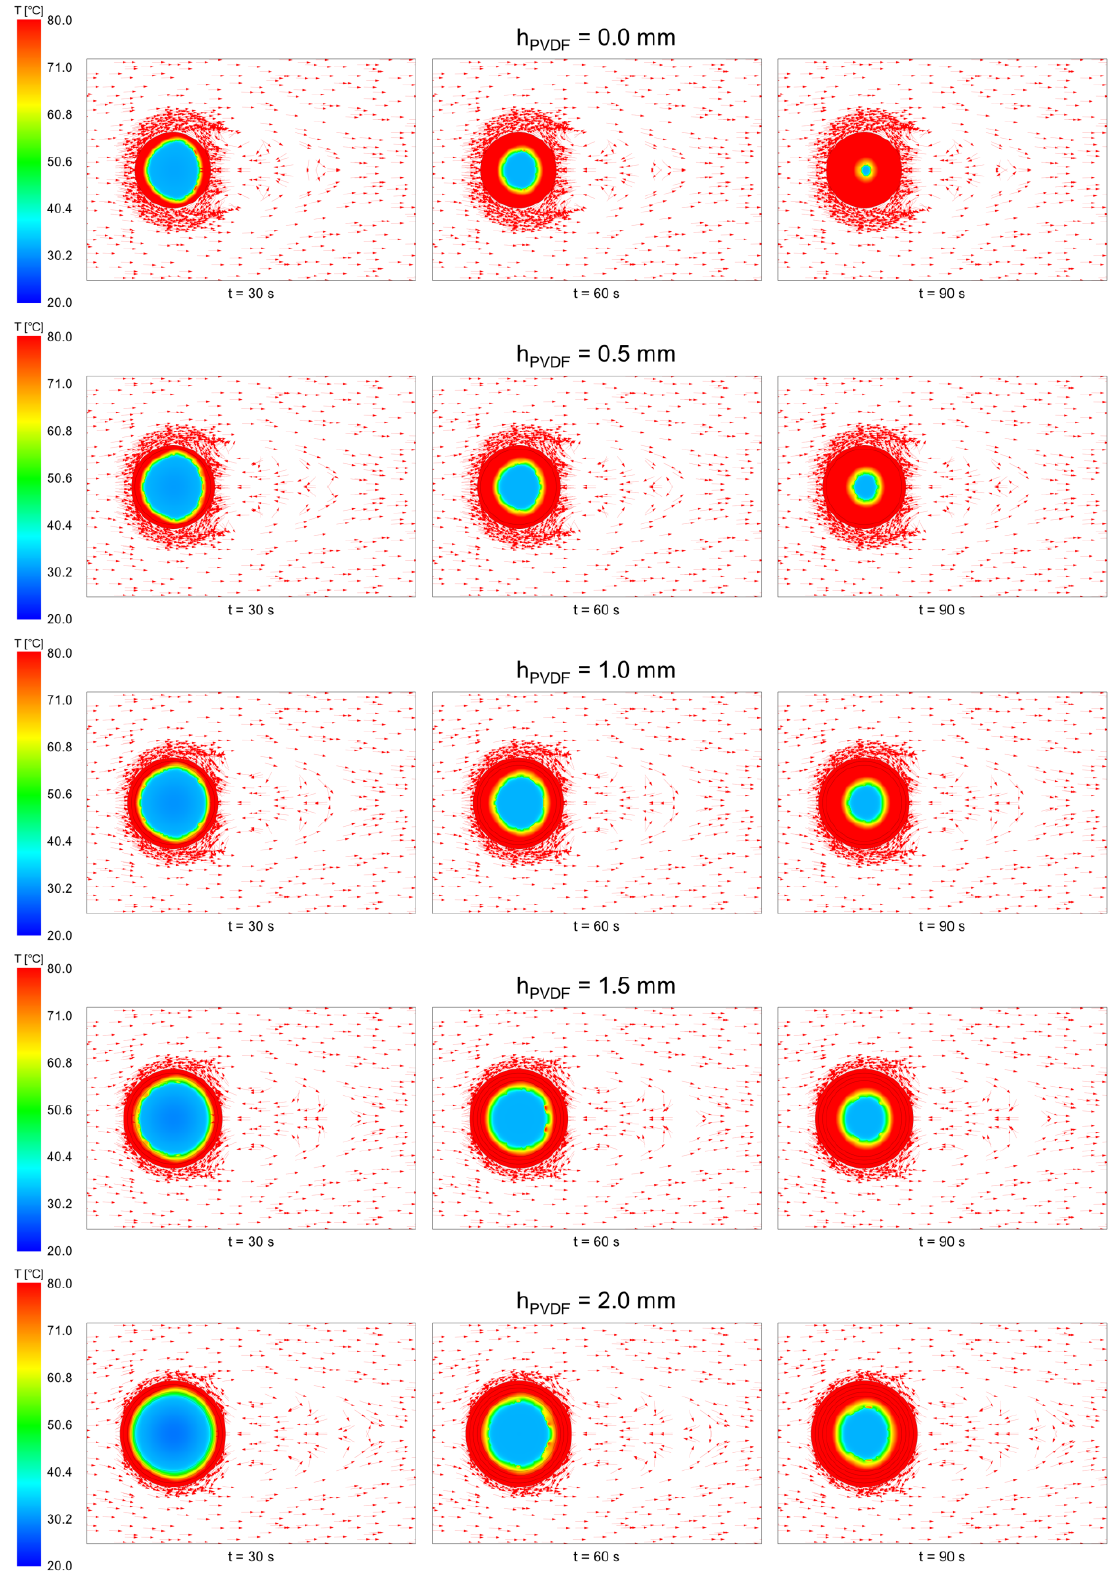
Figure 4. Spatial temperature field of the spherical core-shell particle for different loading times and PVDF shell thicknesses under laminar flow conditions with an ammonia inflow velocity of 30 m/s.